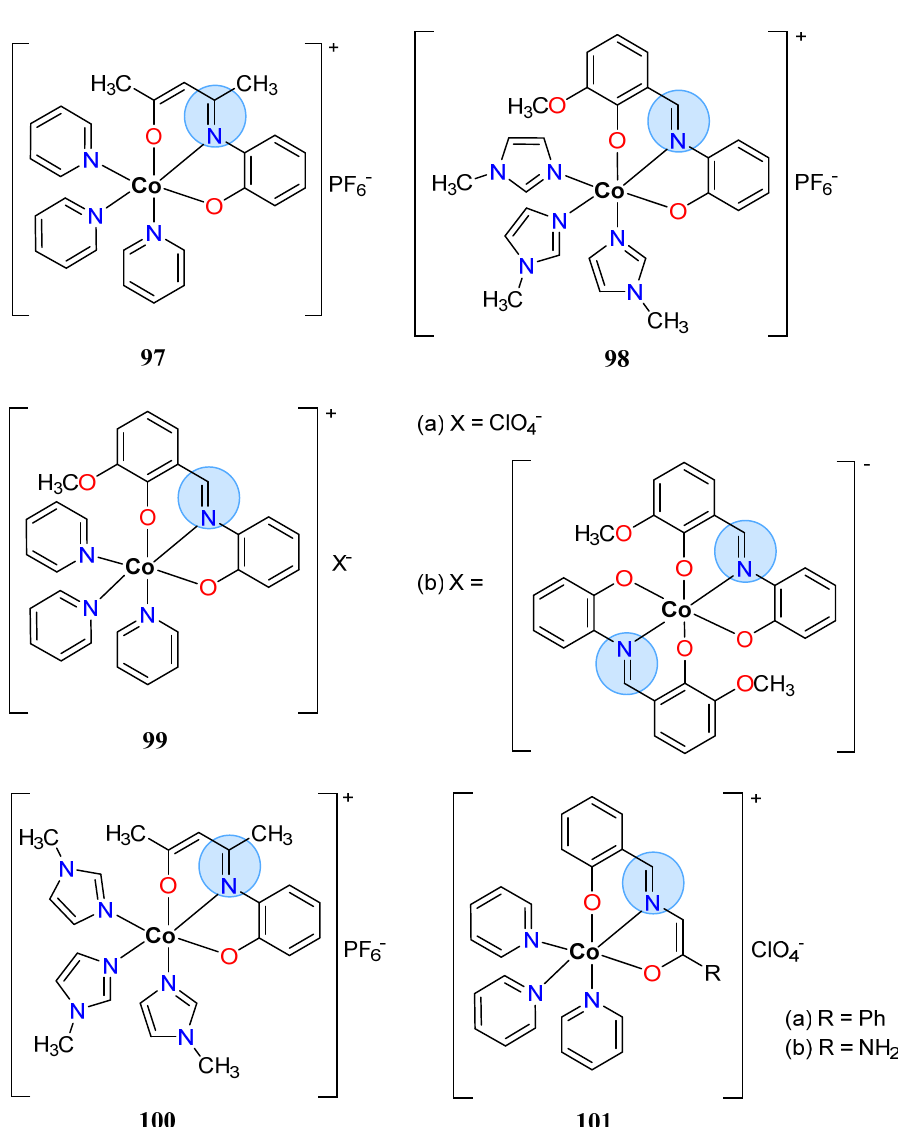
Figure 51. Co(III) complexes with Schiff base ligands (ONO) reported by Kubicki et al. studied for their antibacterial properties.